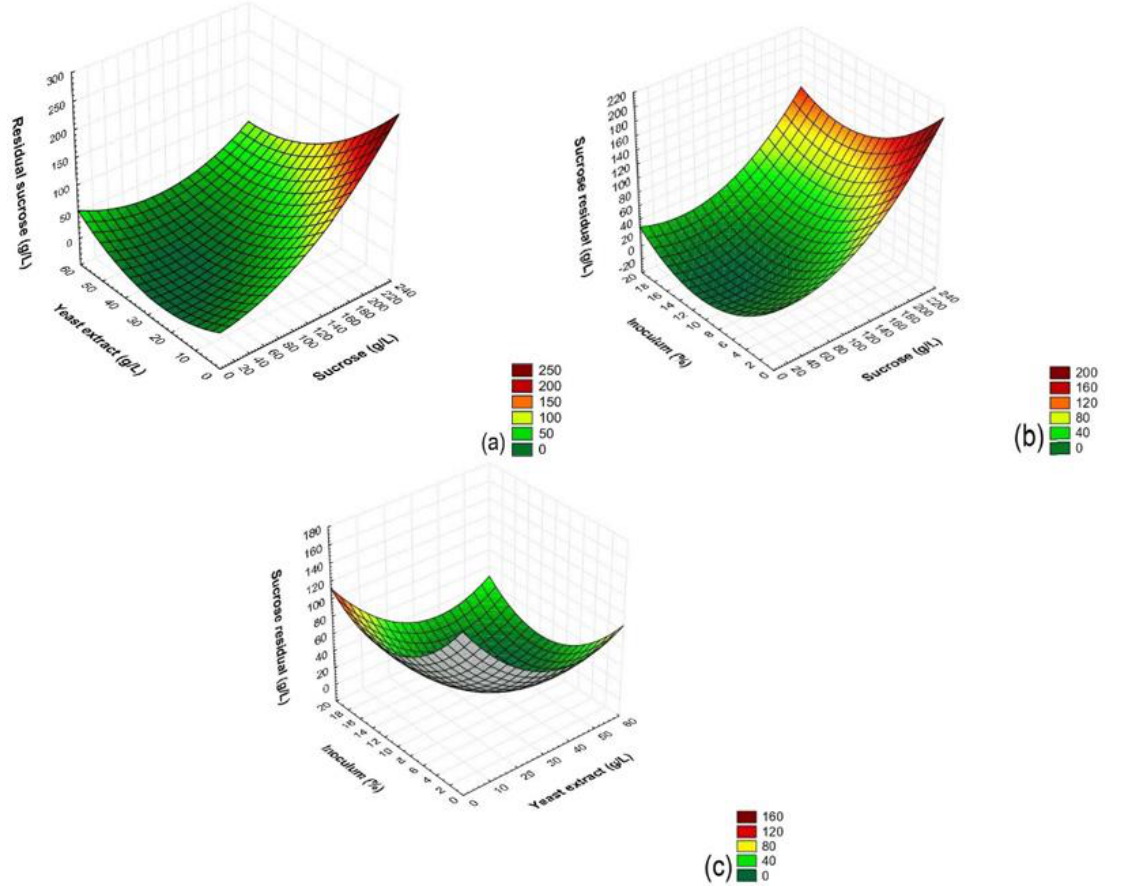
Figure 3. Surface response for residual sugar (residual TRS) in lactic acid production by Lactobacillus casei Ke11 as function of ( a ) sucrose (X 1 ) and yeast extract (X 2 ); ( b ) sucrose (X 1 ) and percentage of inoculum (X 4 ); ( c ) yeast extract (X 2 ) and percentage of inoculum (X 4 ).